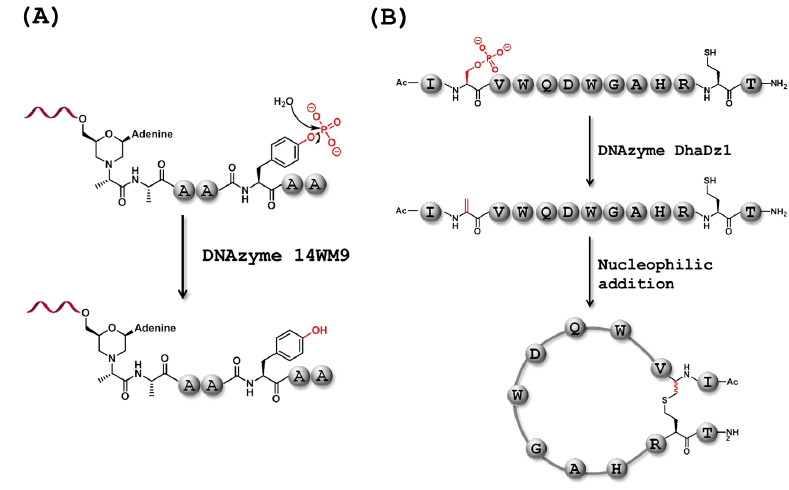
Figure 6. Reactions catalyzed by P-O and C-O bond breaking DNAzymes. ( A ) DNAzyme 14WM9 catalyzes the hydrolysis of phosphomonoesters on amino acid side-chains [137]; ( B ) DNAzyme DhaDz1 catalyzes the elimination reaction of a phosphate group of a serine side-chain [139].